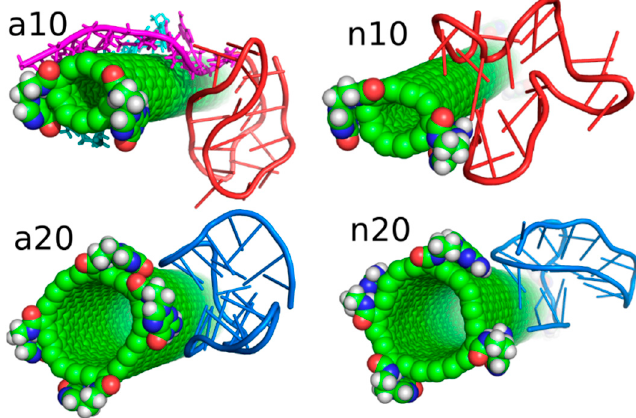
Figure 6. Architectural details of the essential interaction sites found in the considered systems.